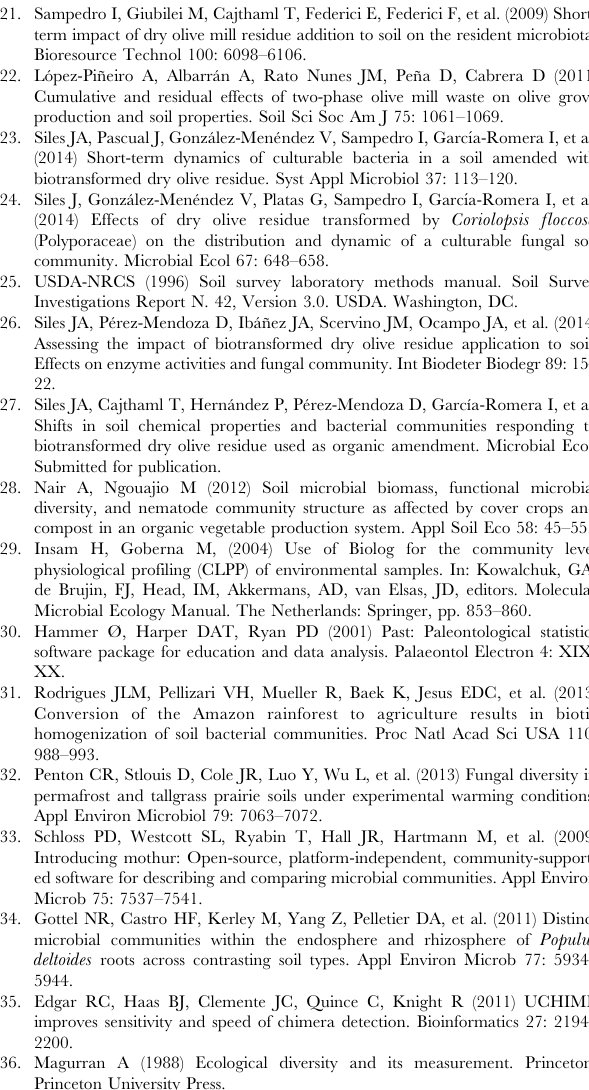
Table S4 Identification and abundance of the major fungal OTUs. Basic information of the fungal 14 most abundant OTUs and their relative abundance (percent) in unamended soil (C)